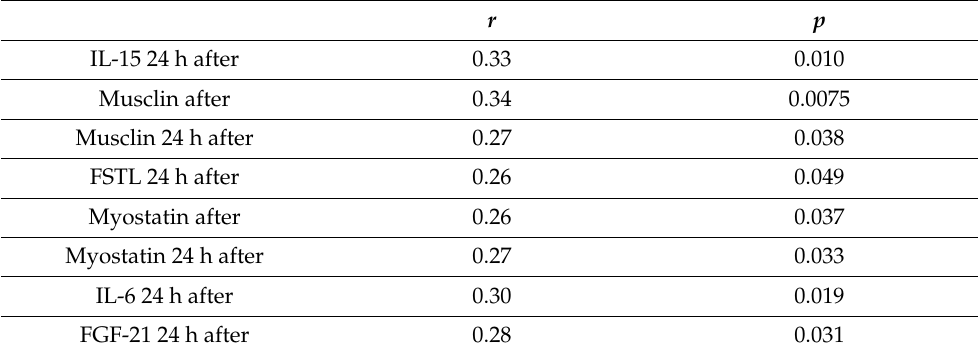
Table 5. Correlation of vitamin C with myokines after the race. r p IL-15 24 h after 0.33 0.010 0.34 0.0075 0.038